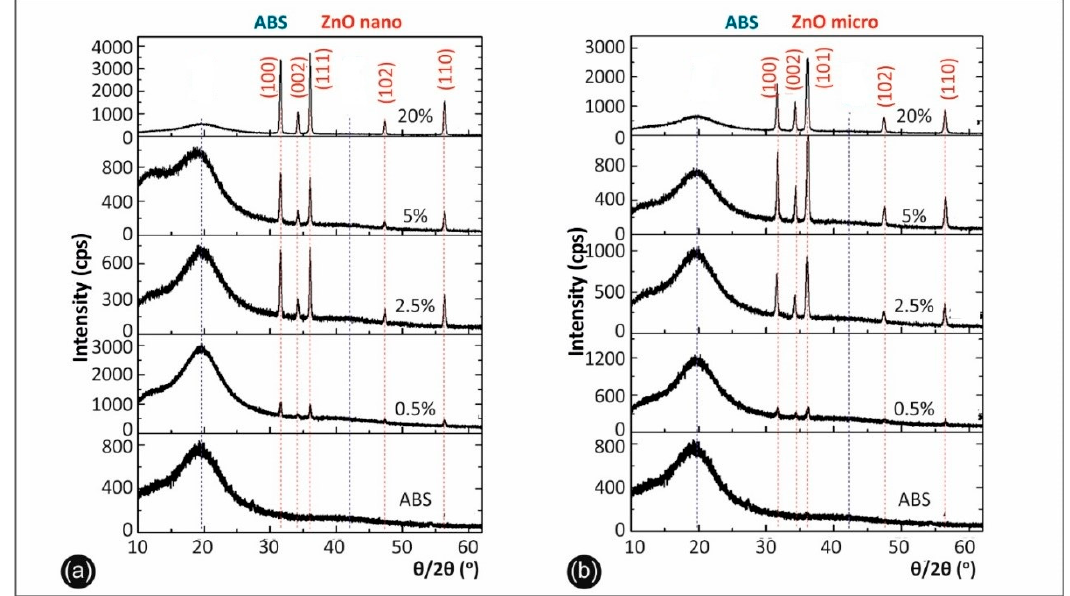
Figure 2. ( a ) X-ray diffraction (XRD) spectra of ABS/ZnO nanocomposites and ( b ) XRD spectra of ABS/ZnO micro-composites in concentrations studied.